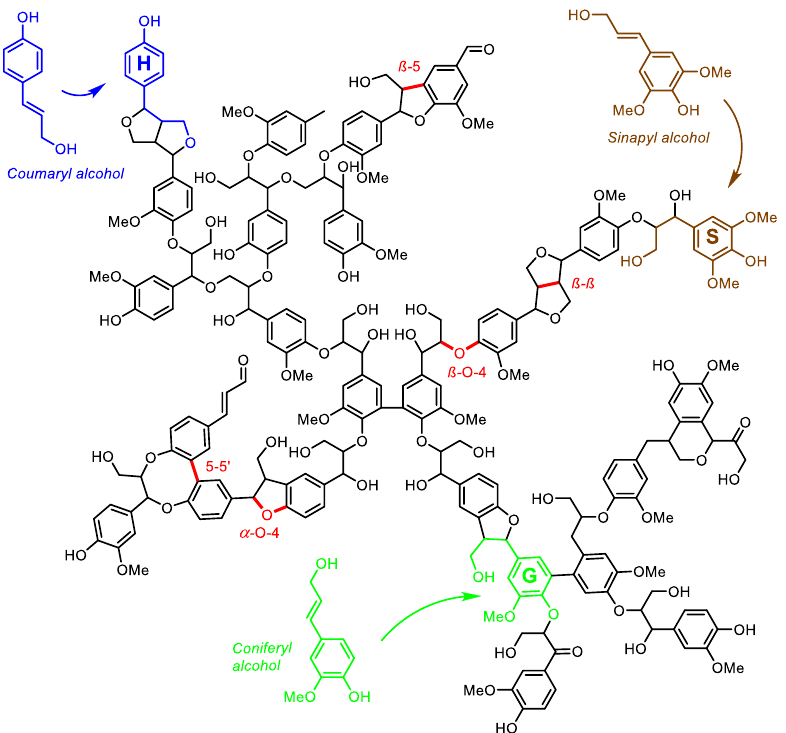
Scheme 1. Typical part of the structure of lignin. Basic building blocks, sinapyl alcohol (M = 210.23 g/mol), coniferyl alcohol (M = 180.20 g/mol), and coumaryl alcohol (M = 150.18 g/mol), and selected bond types are highlighted; simplified structure of lignin, see also [16].